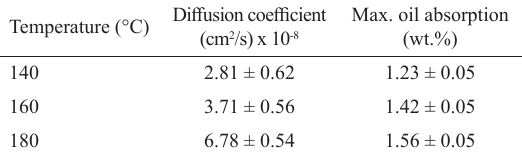
Table 1: Diffusion coefficient and maximum oil absorption